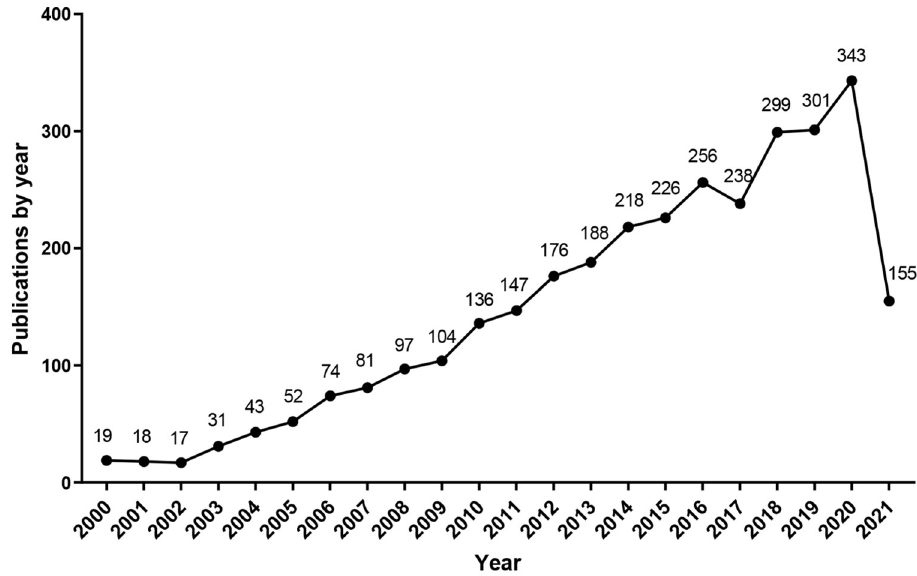
Fig 2. Distribution of publications by